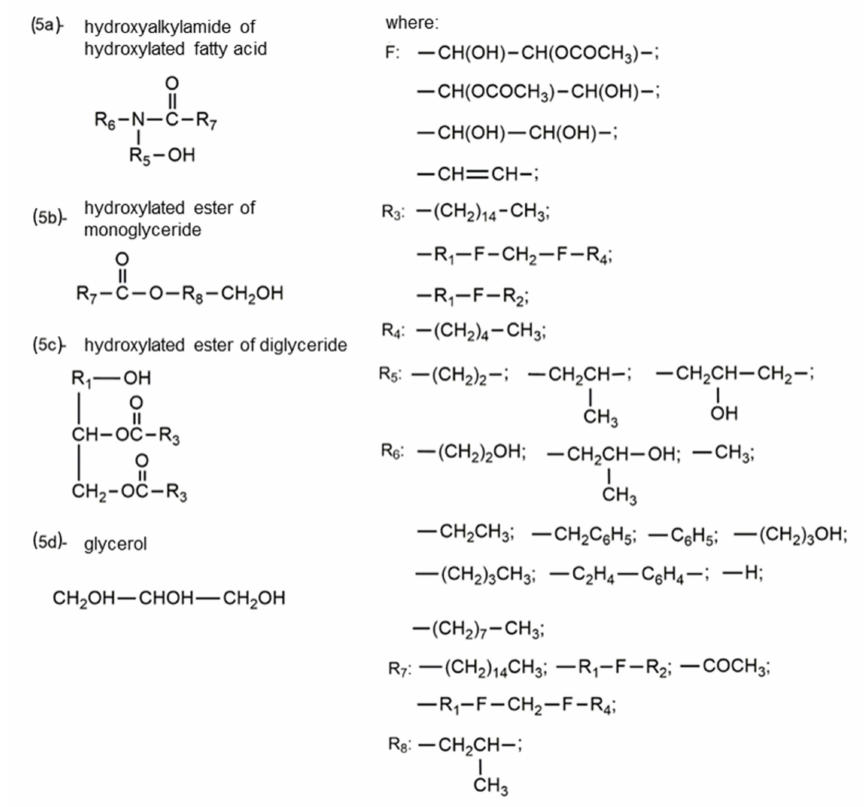
Figure 5. General chemical structures of secondary polyols, formed as a result of aminolysis of primary polyols with hydroxyalkylamines: hydroxyalkylamide of hydroxylated fatty acid ( 5a ), ester of hydroxylated monoglyceride ( 5b ), ester of hydroxylated diglyceride ( 5c ) and glycerol ( 5d ). R 1 , R 2 , R 3 , R 4 as in Figure